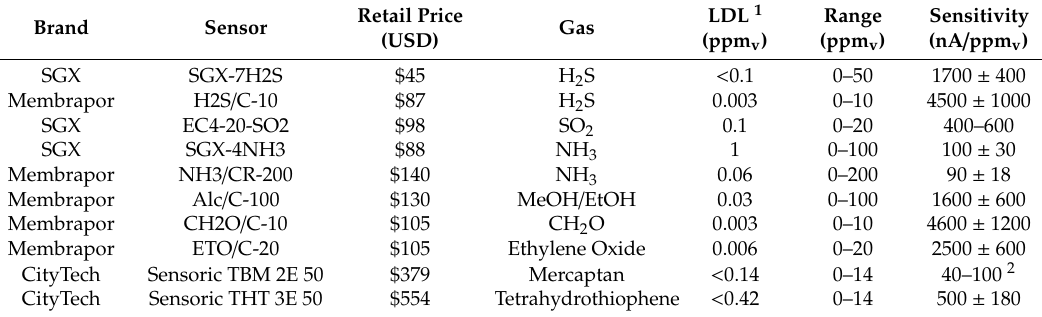
Table 2. List of sensors and their characteristics (all sensors are